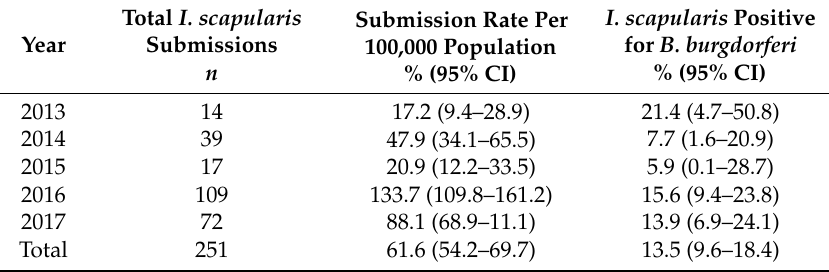
Table 2. I. scapularis submission rates per 100,000 population and B. burgdorferi status submitted through passive tick surveillance in the NWHU catchment area from 2013 to